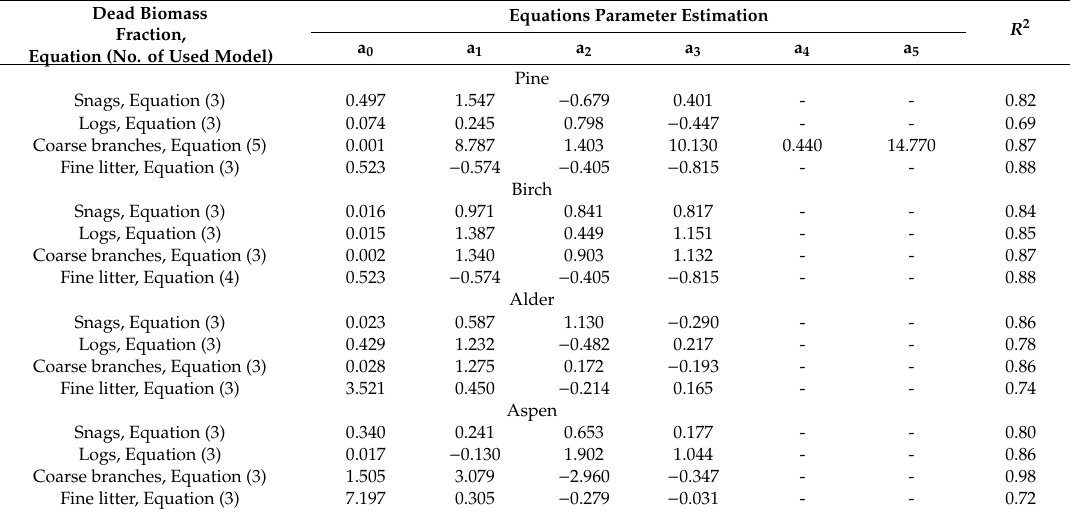
Table A1. Parameters of forest dead biomass from Equations (3)–(5).